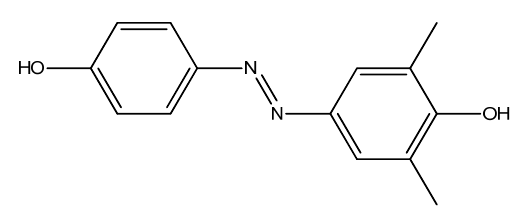
Figure 1. Chemical structure of lead compound A4 [16].